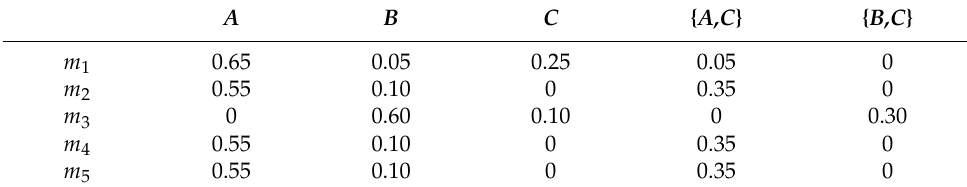
Table 7. The basic probability assignment (BPA) of multi-sensor